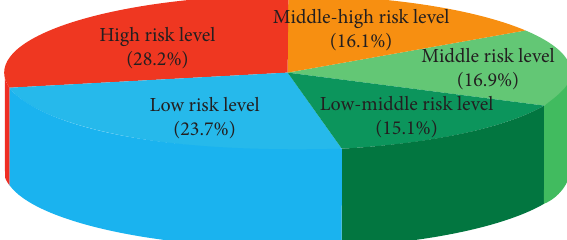
Figure 7: Proportion of risk levels in the test set.